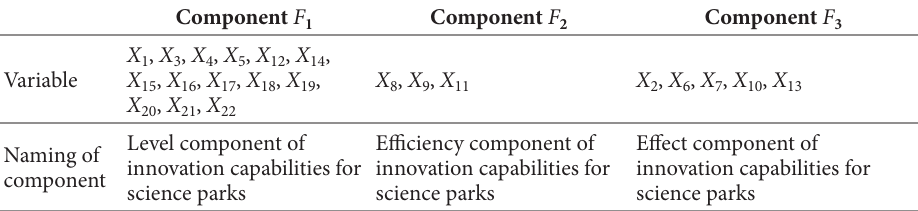
Table 5. Naming of